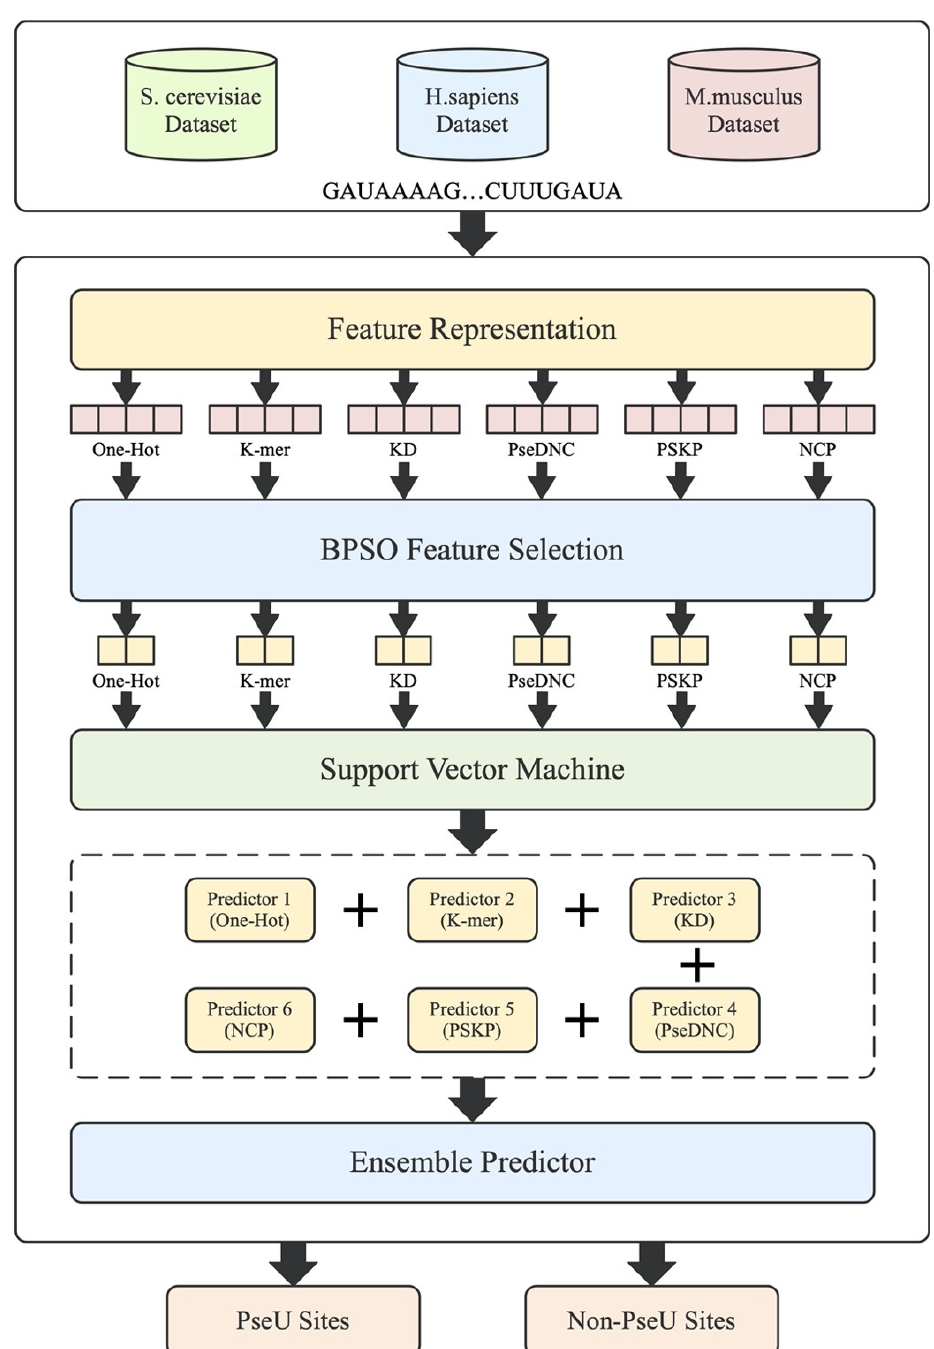
Figure 1. The framework of the proposed PsoEL-PseU predictor. The RNA sequences in the dataset are represented by feature descriptors, followed by filtering using the BPSO algorithm; finally,